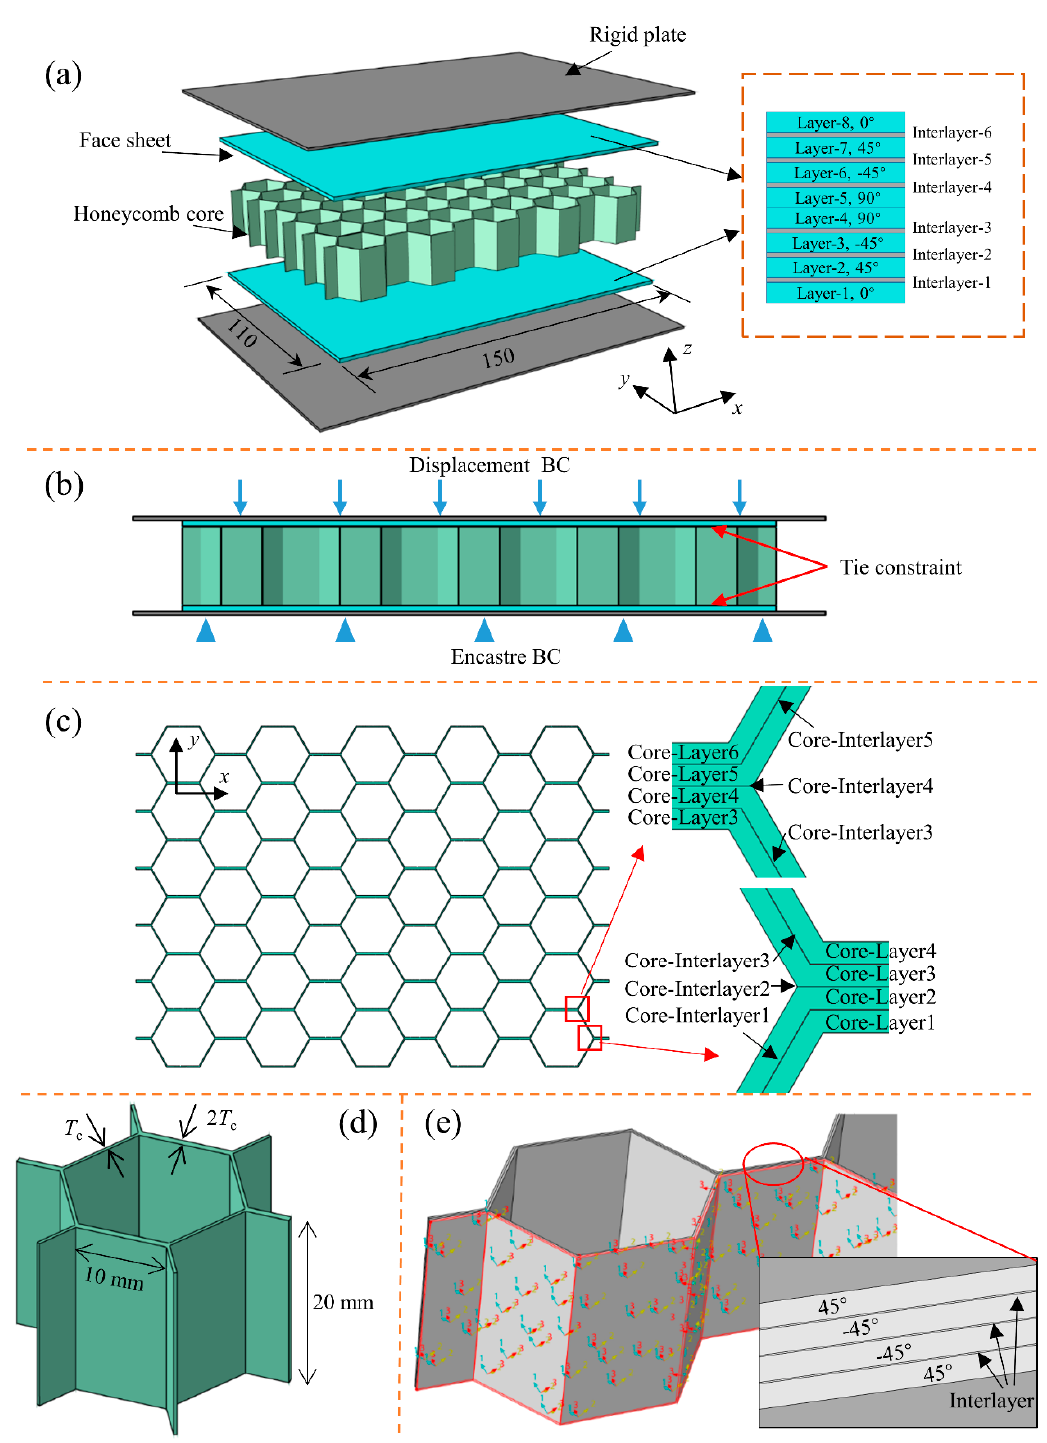
Figure 4. Finite element model of all-composite sandwich structure with honeycomb core under out-of-plane quasi-static compression: ( a ) compression model, ( b ) boundary conditions, ( c ) layer details of honeycomb core, ( d ) cell of honeycomb core, and ( e ) material direction of honeycomb core. In addition, according to the experimental results in the literature [15,37], there is almost no debonding at the interface of the face-sheet/core during the compression pro- cess. Therefore, in order to improve the computational efficiency, ‘Tie’ constraints are ap- plied to the interface of the face-sheet/core. All degrees of freedom of the rigid plate below are constrained, and the rigid plate above is subjected to a displacement load. In order to